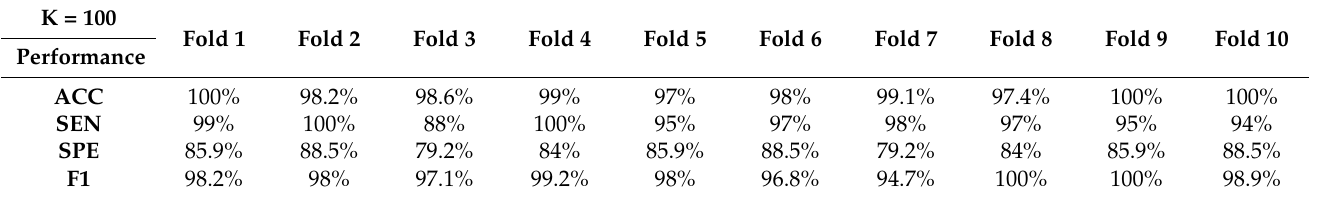
Table 5. The suggested method’s performance metrics after being subjected to ten-fold cross- validation with the softmax classifier.